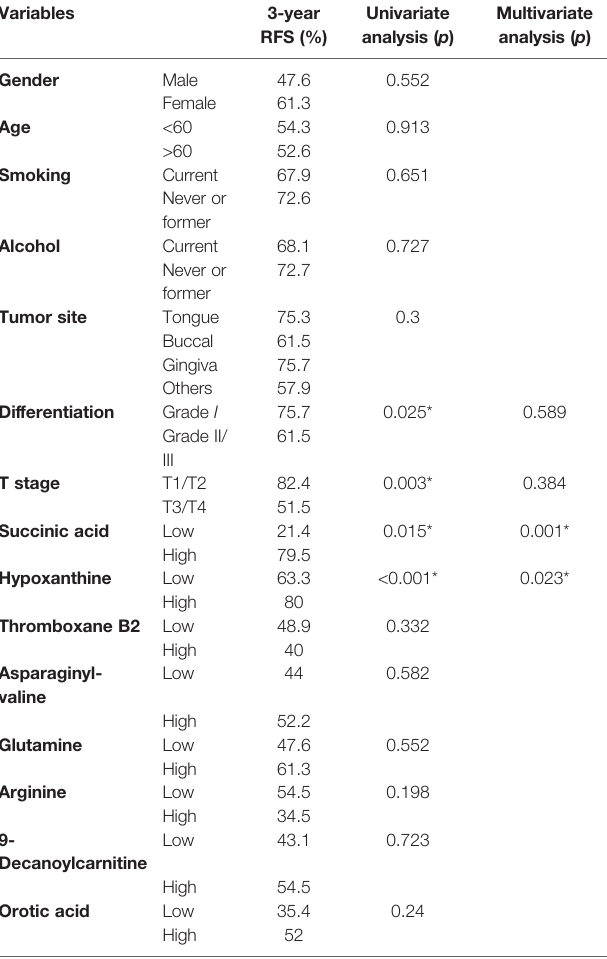
TABLE 2 | Univariate and multivariate survival analysis of clinicopathological parameters. Variables 3-year